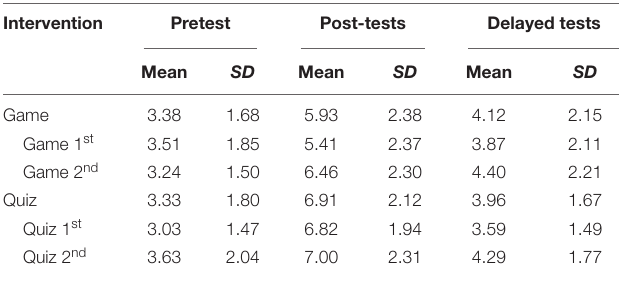
TABLE 1 | Descriptive statistics of results from pretests, immediate post-tests and delayed tests by intervention type and test position within session. Intervention